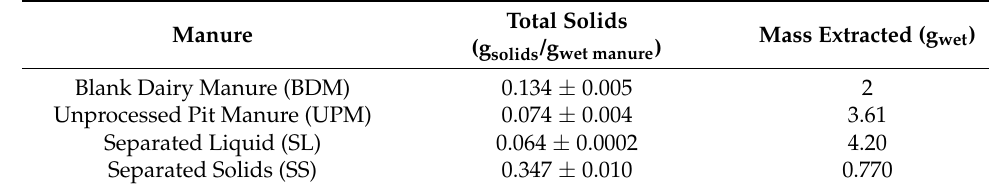
Table 2. Total solids (TS) of the manure used in this study, and the wet mass used in the extraction experiments based on a TS of 0.25 g/g manure for extraction. Solids are reported as average values (n = 3) with ± standard error.